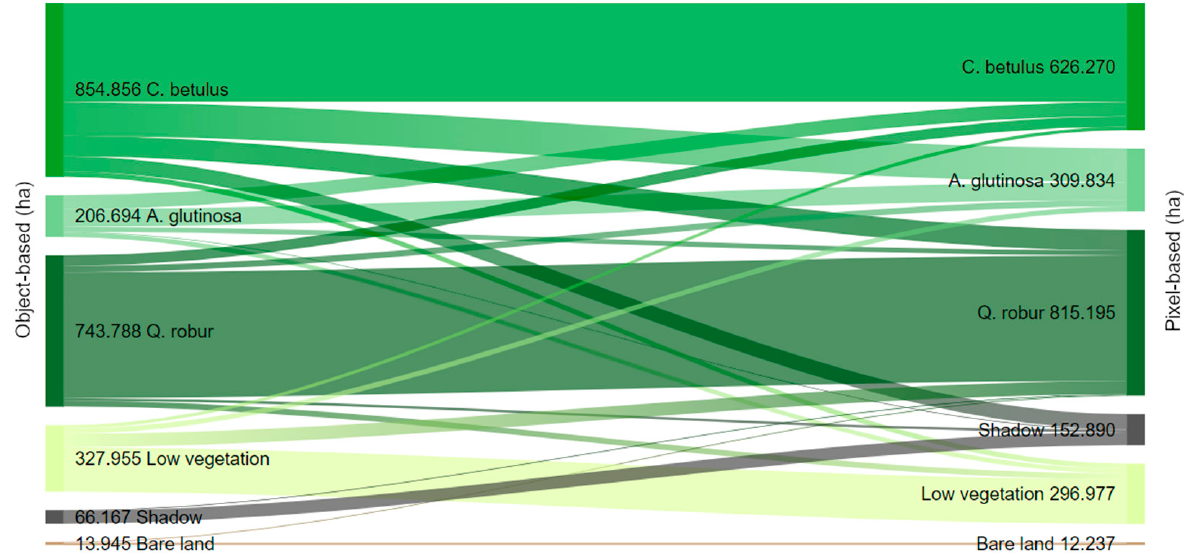
Figure 6. The scattering of six land-cover classes ( Alnus glutinosa, Carpinus betulus, Quercus robur , bare land, low vegetation, and shadow) for the entire study area obtained with pixel- and object-based classification of LMVM pansharpened imagery.